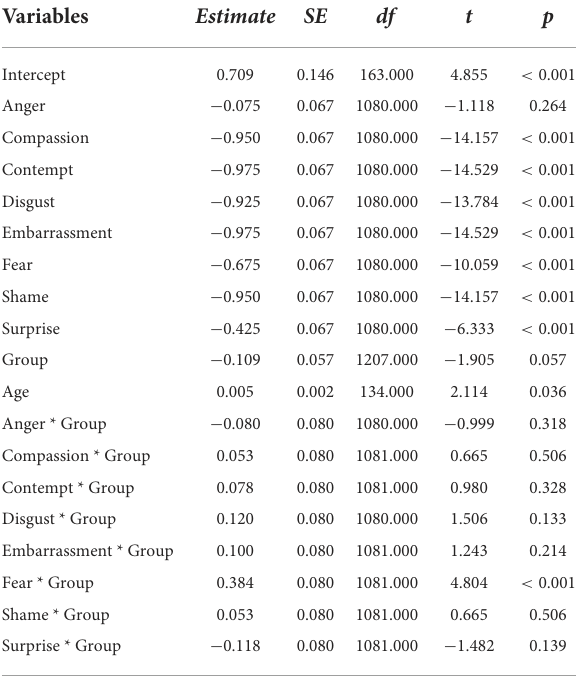
TABLE 2 Adult faces task: association with pandemic-related changes in social interactions.